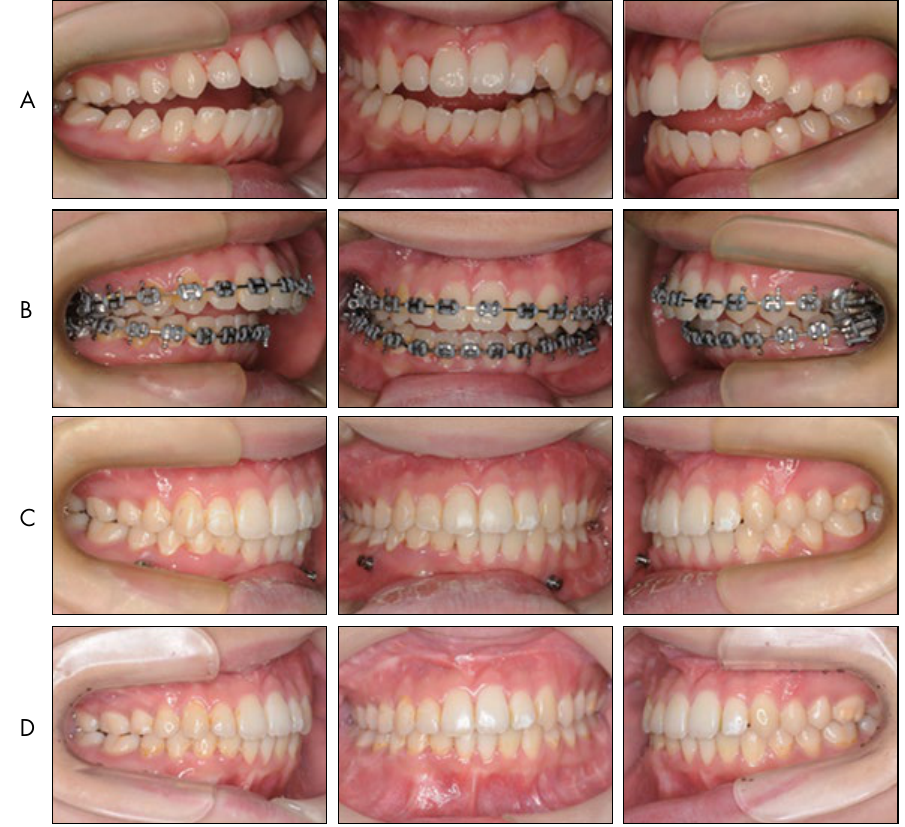
Figure 3. Oral photographs. A: pretreatment; B: pre-surgery; C: post-treatment, one year after surgery; D: post-retention, two years and six months after